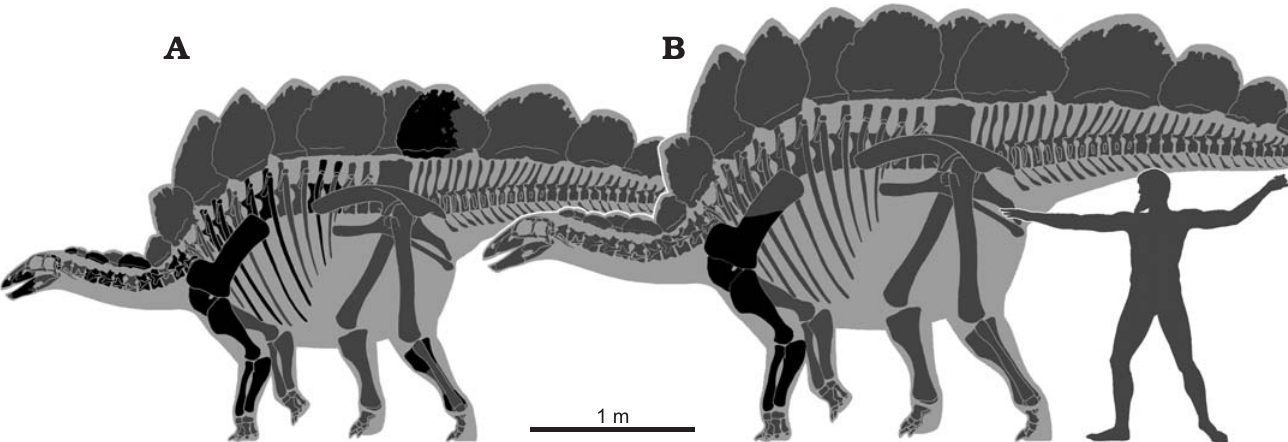
Fig. 2. Skeletal reconstruction of the stegosaurs GPDM 178 ( A ) and GPDM 205 ( B ) scaled together based on humeral lengths. Black, elements preserved in each specimen; gray, missing elements. Hesperosaurus reconstruction by Genya Masukawa (Ibaraki University, Japan). Human scale is the Artemision Bronze featuring the deity of Zeus as 1.83 m in height.